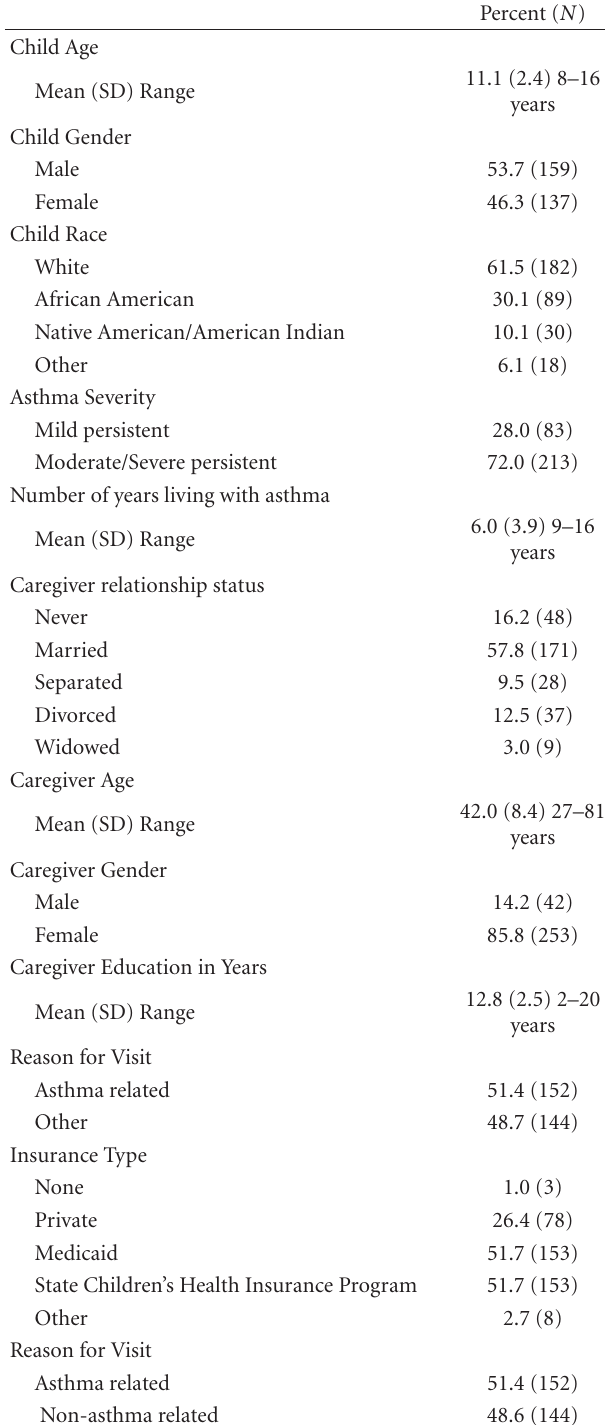
Table 1: Child and caregiver demographic characteristics ( N =